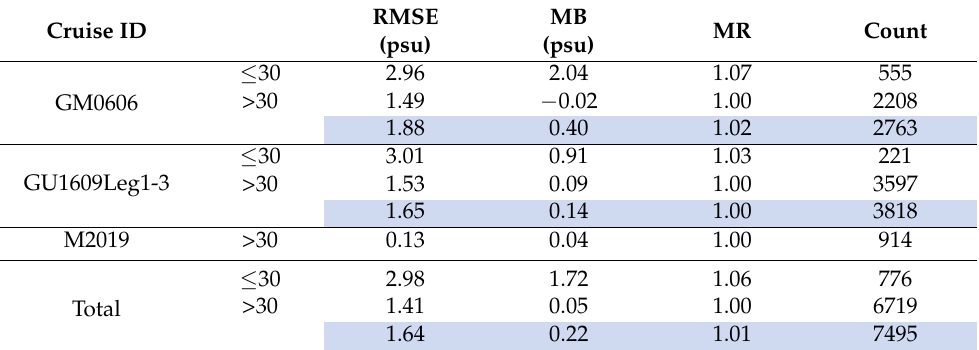
Table 5. Independent validation of the SSS model, the overall result of each cruise was listed with blue background, the cruise GU1609Leg1-3 Fall Pelagic Trawl/Acoustic Survey was listed as GU1609Leg1-3 for convenience.